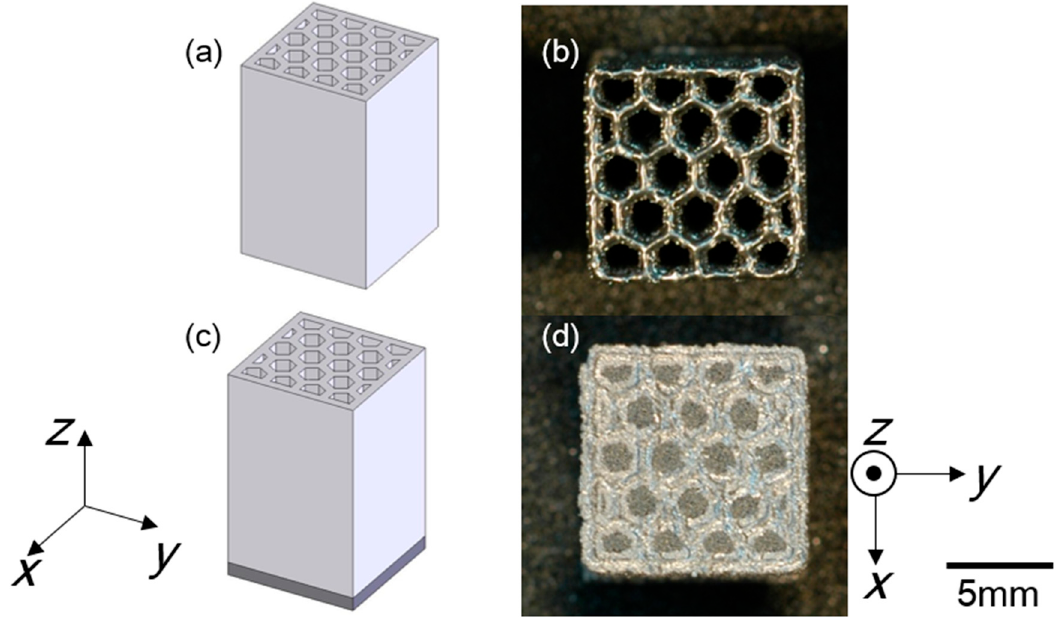
Figure 1. Three dimensional image of CAD model and pictures of specimen top surface for ( a , b ) porous specimen with elongated honeycomb pores and ( c , d ) powder/solid composite with un-melted powder particles within the pores (composite specimen).